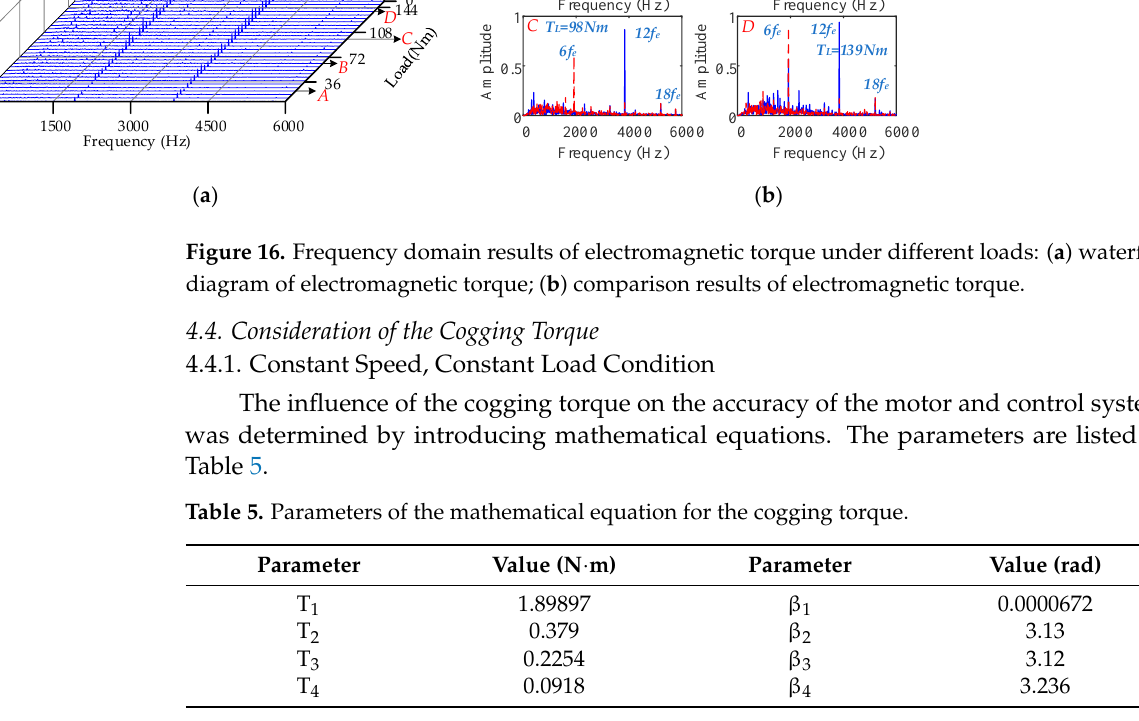
Table 5. Parameters of the mathematical equation for the cogging torque.